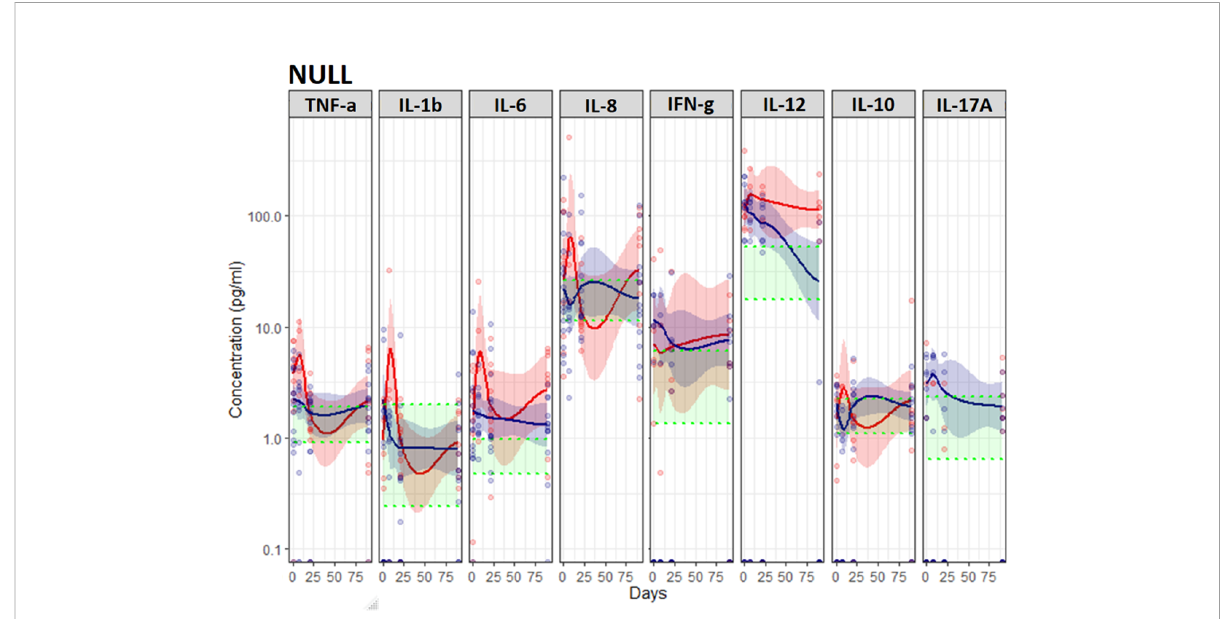
FIGURE 6 Unstimulated immune response assessed by TruCulture ® (NULL) in NSCLC patients During treatment with chemotherapy (CT) in patients